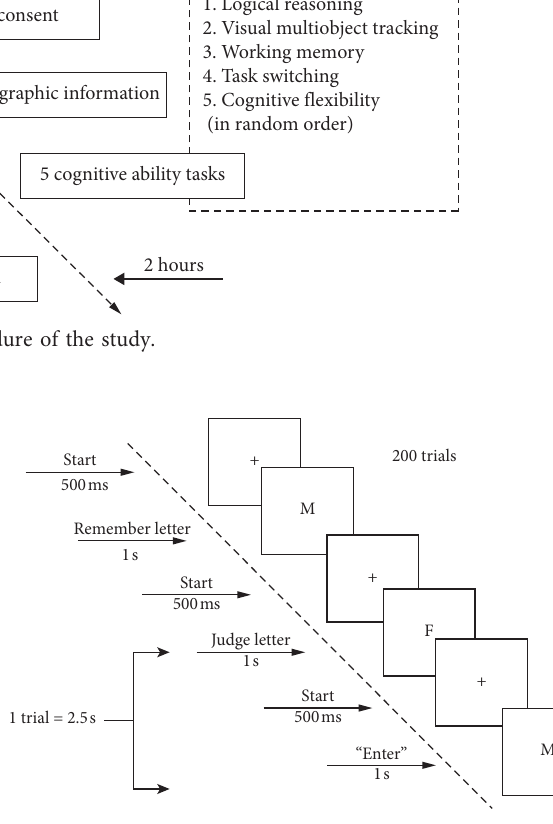
Figure 4: Conceptual illustration of the 2-back task.